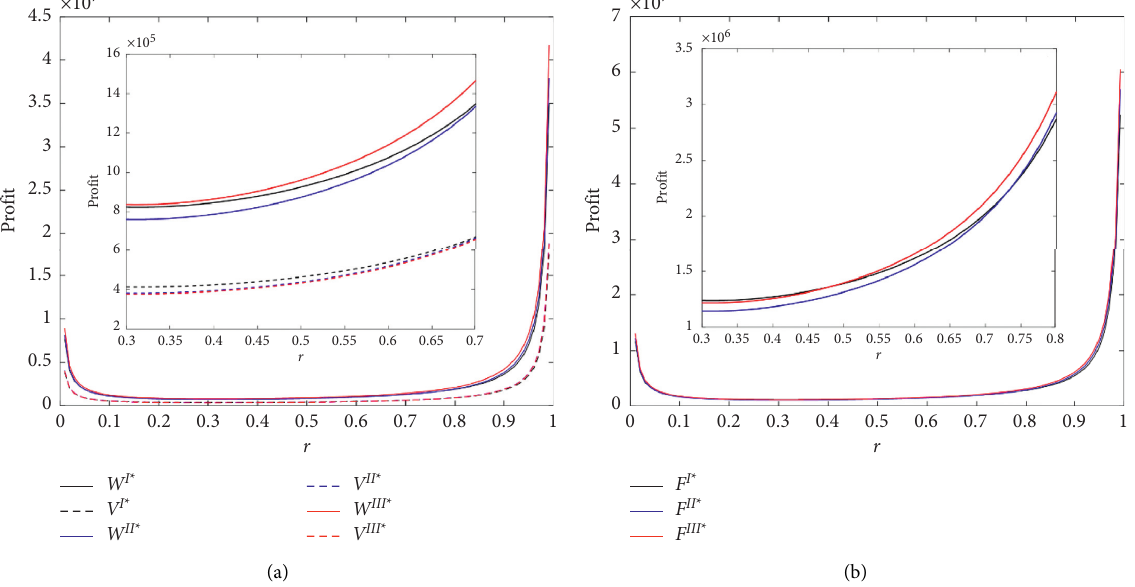
Figure 4: The effects of r on profits. (a) Supply chain members. (b) Supply chain system.